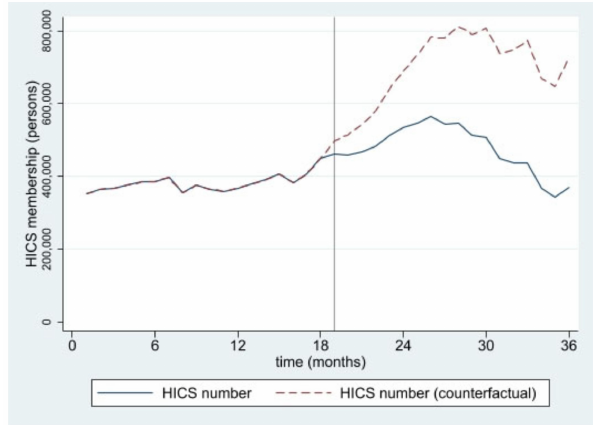
Figure 6. HICS membership, border provinces